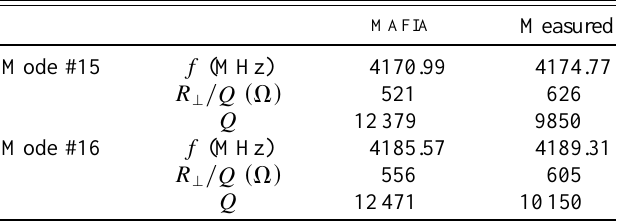
FIG. 8. Measurement: longitudinal (cid:69) field of mode #16.